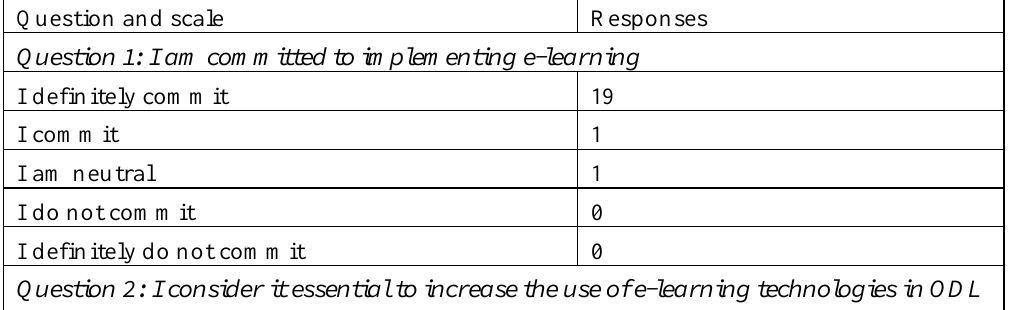
Faculty Committing to the Use of TEL